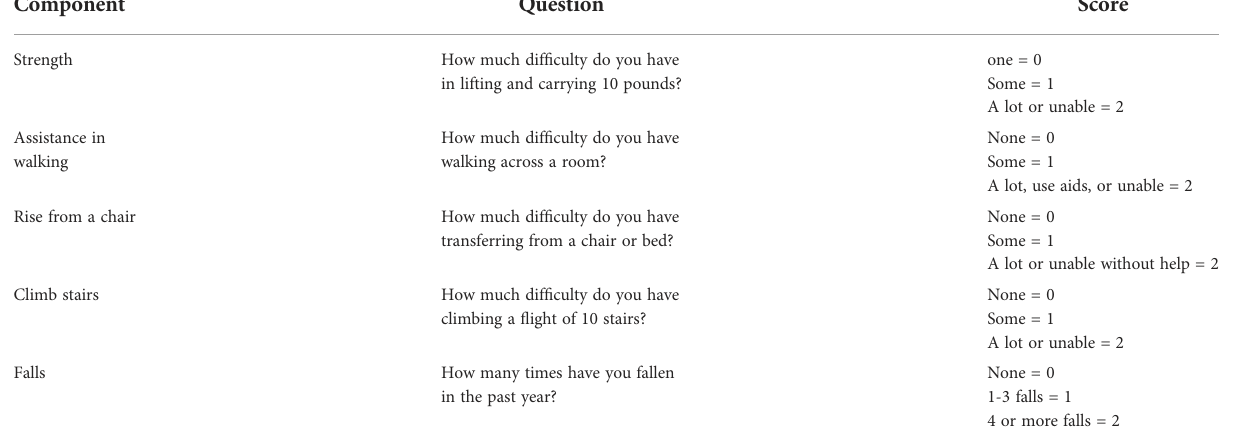
TABLE 2 SARC-F questionnaire.